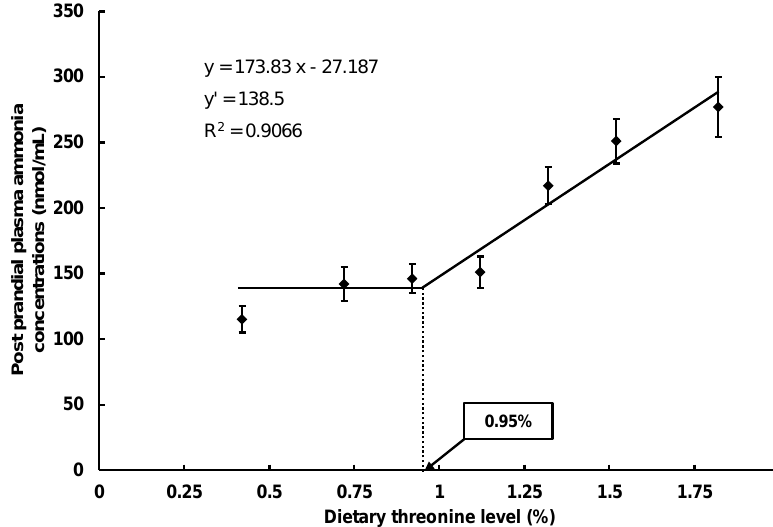
Figure 3. Broken line analysis of post-prandial plasma ammonia concentrations (nmol/mL) in rainbow trout fed graded levels of dietary threonine. Values of the X-axis are the threonine levels in the experimental diets. Values are means±standard deviation of 5 replicates. Y = 173.83x–27.187, Y ' = 138.5, R 2 =